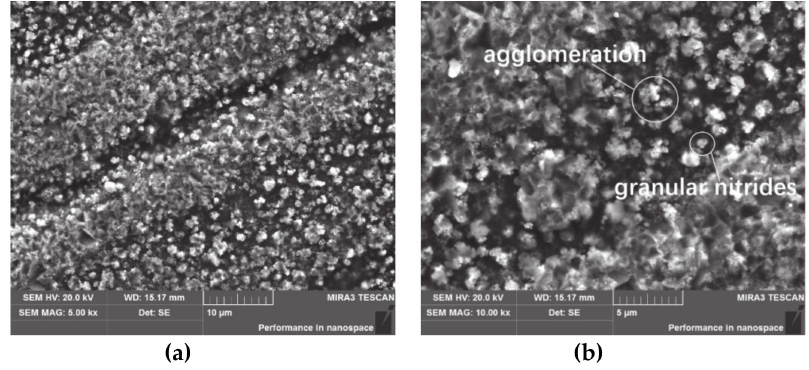
Figure 3. The SEM image of a plasma-nitrided specimen. ( a ) 5000 × ; ( b ) 10,000 × .